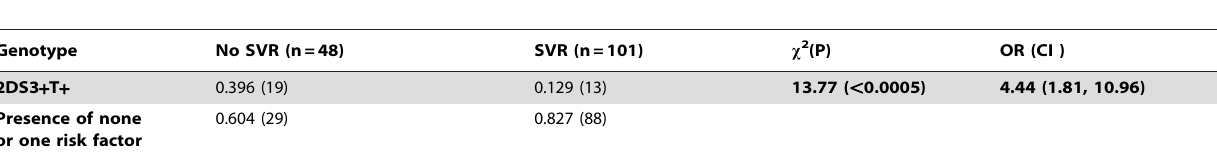
Table 4. The presence of both IL28B - T and KIR2DS3 significantly increased the odds of HCV treatment failure.